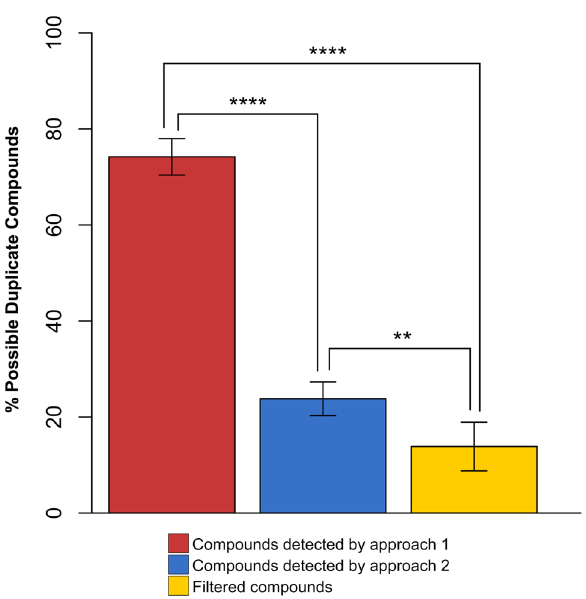
Figure 5. Possible Duplicate Compounds. Statistical comparisons between percentages each subset of possible duplicate compounds in compounds detected by first approach, compounds detected by second approach and filtered compounds were performed with two tailed ANOVA test followed by Bonferroni post-hoc tests ( p value < 0.01(**), p value < 0.0001